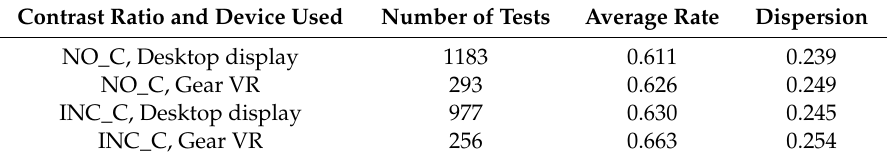
Table A14. Numerical results of the users regarding the contrast ratio and device